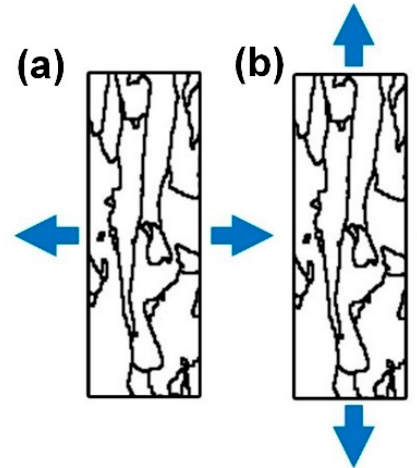
Figure 9. The grain boundaries from the XOZ plane when the load was ( a ) perpendicular to the long axis of columnar grains and ( b ) parallel to the long axis of columnar grains.